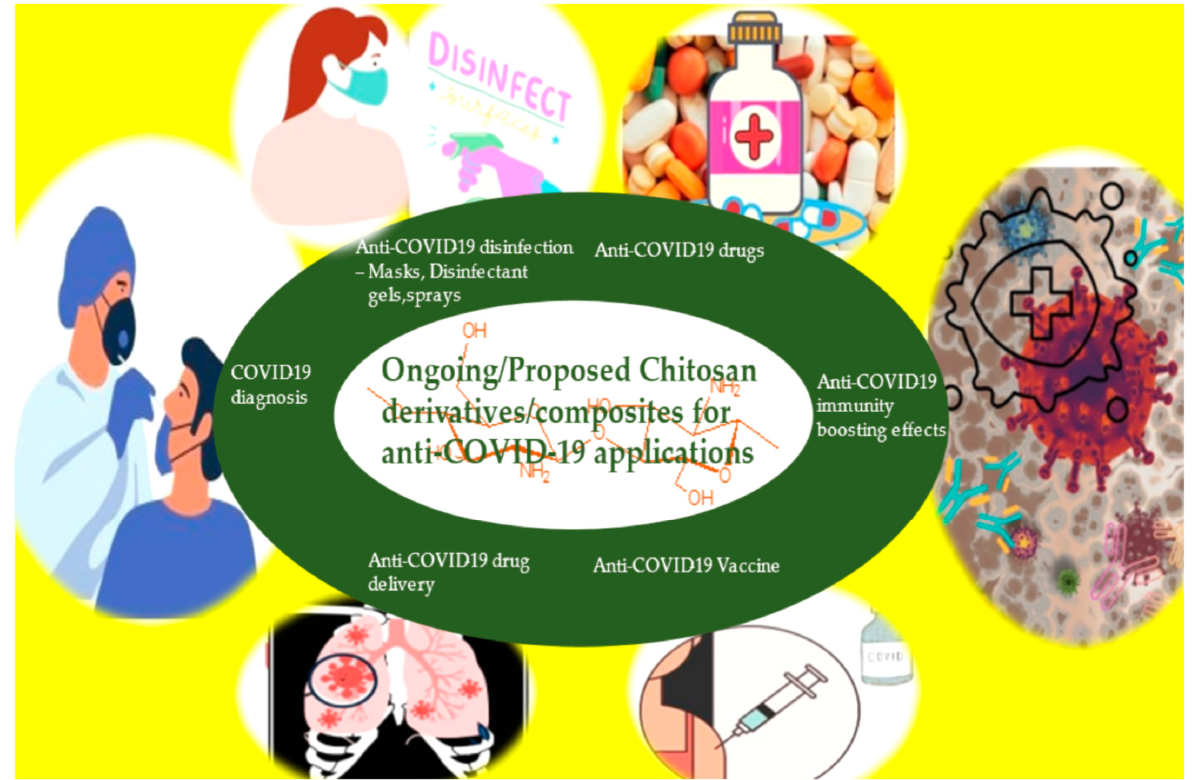
Figure 3. Contributions of chitosan derivatives to combat various anti-COVID-19 challenges.